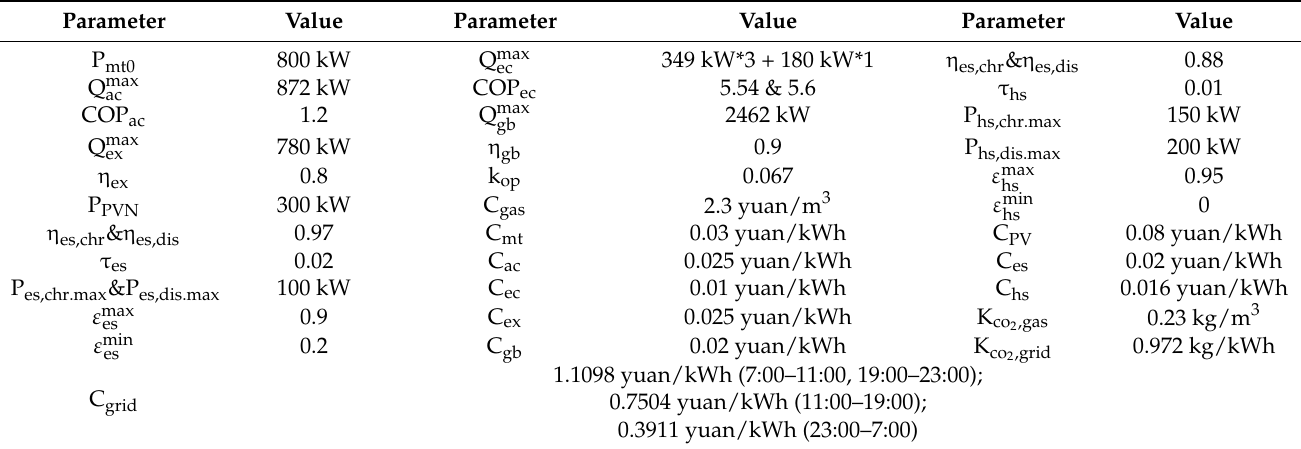
Table 3. The CCHP system energy station equipment parameter table of The Westin Xi’an